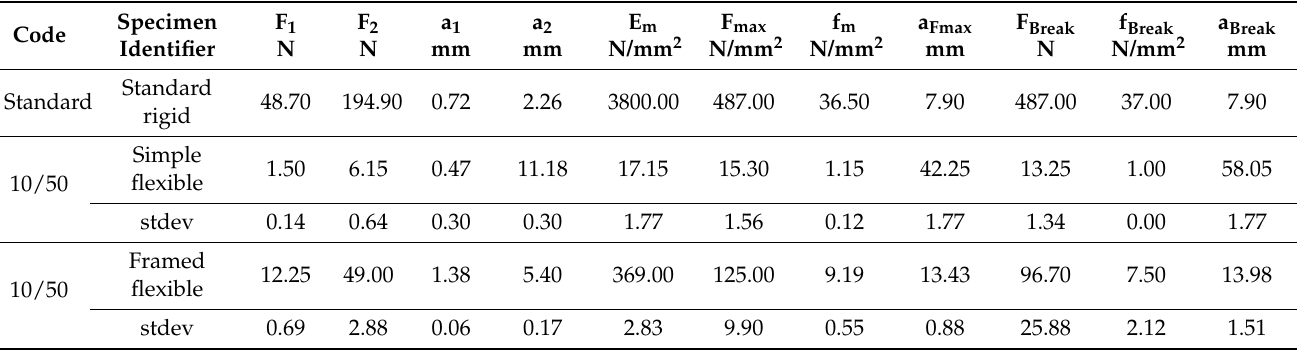
Table 1. Results of static bending (mean values and standard deviation) for standard, simple flexible, and framed flexible samples.